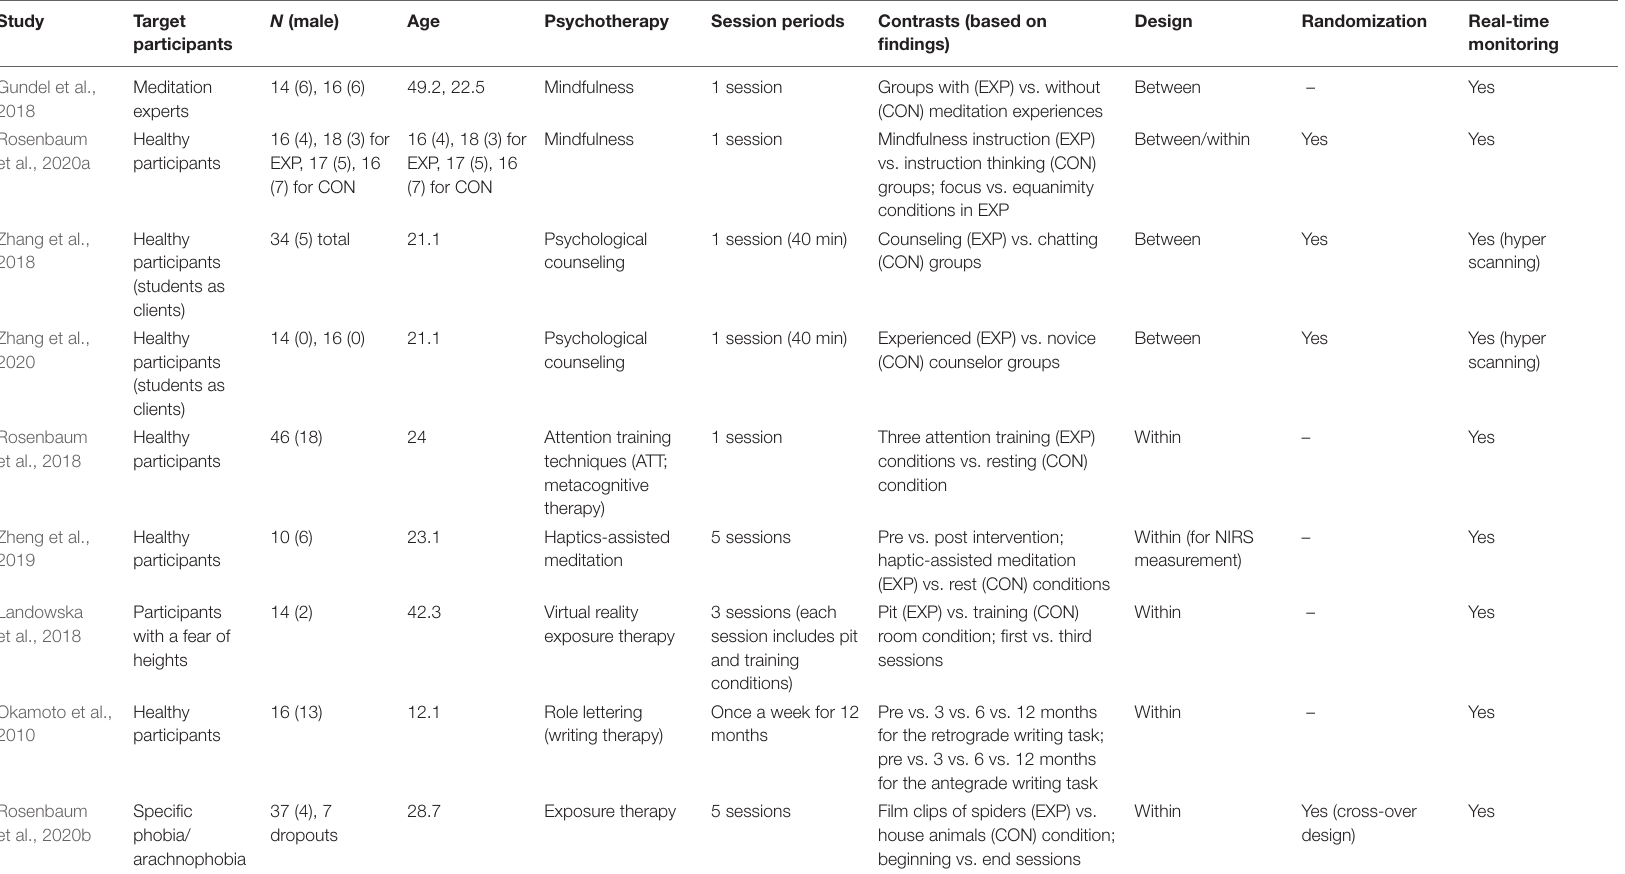
TABLE 1 | Experimental designs of studies that evaluated psychotherapeutic effects using hemodynamic response changes.